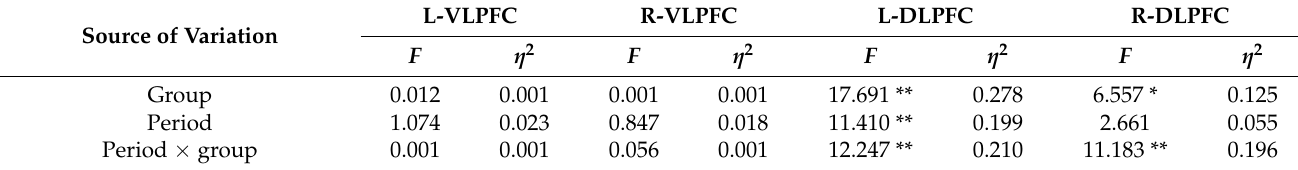
Table 4. The fNIRS data variance (ANOVA) analysis of the effect of orienteering exercises on the spatial memory ability of college